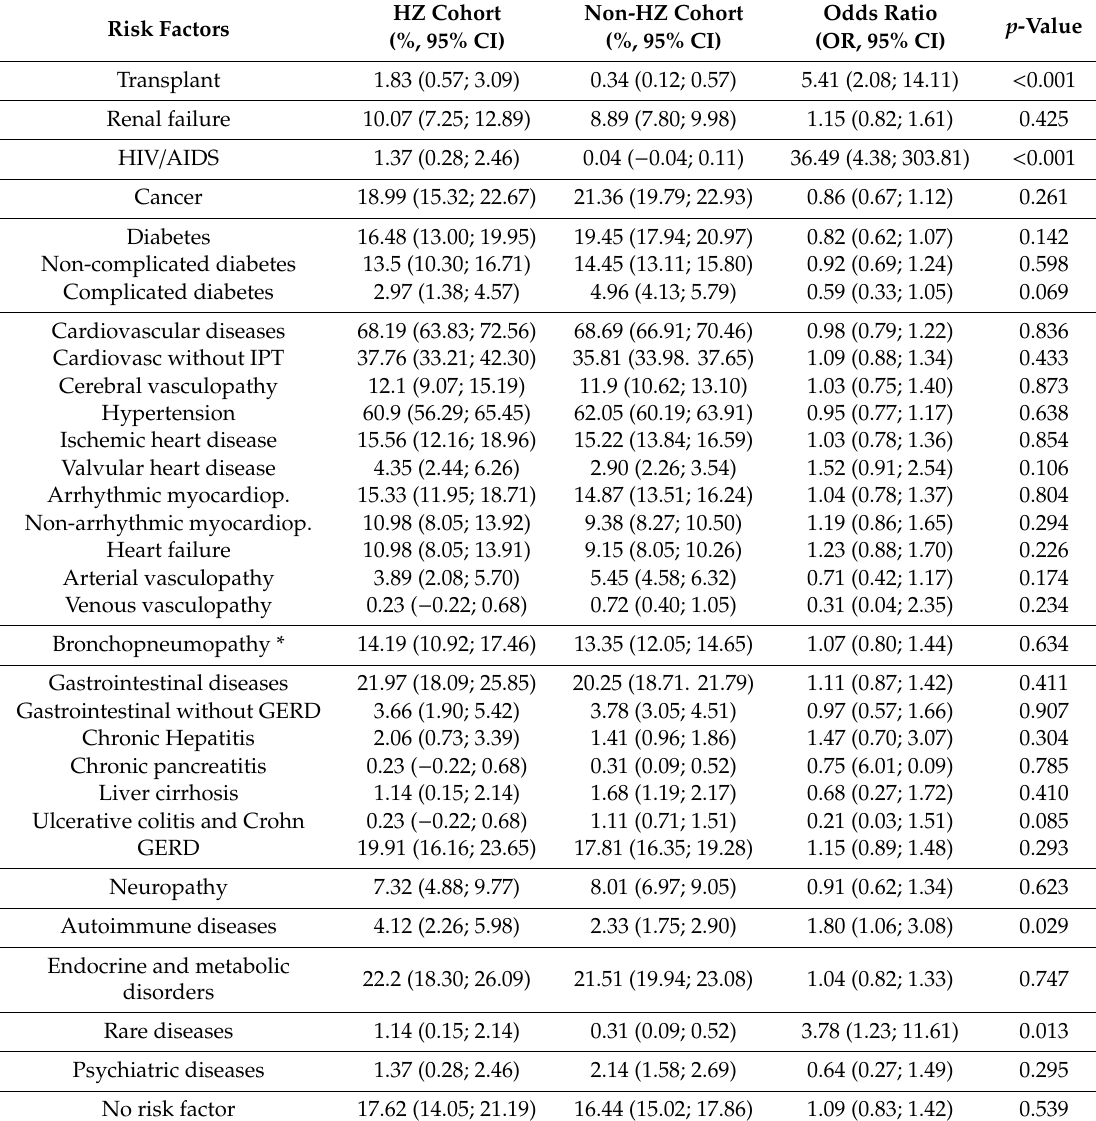
Table 1. Prevalence of chronic diseases at 6 months before hospitalization in HZ cohort and non-HZ cohort; period